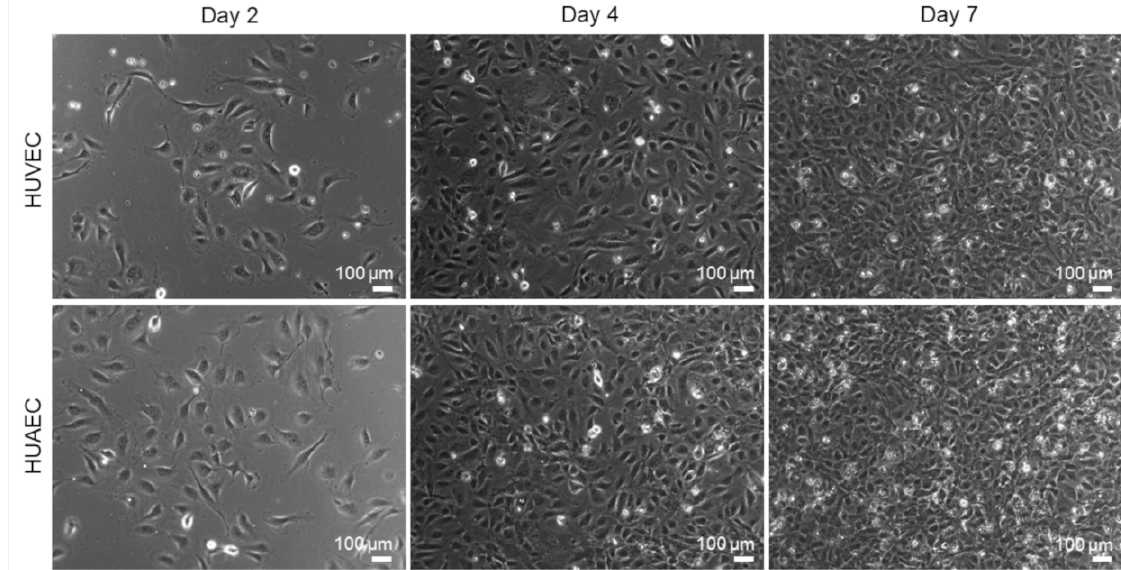
Figure 1. Morphology of endothelial cells. Human umbilical cord-derived endothelial cells from veins (HUVEC) or arteries (HUAEC) were seeded at a density of 15,000 cells/well at day 0, and cultivated for 2, 4, and 7 days. Phase contrast images were taken at 10-fold primary magnification. Cells developed the typical cobblestone-like morphology of mature endothelial cells with increasing proliferation time. Scale bar represents 100 µ